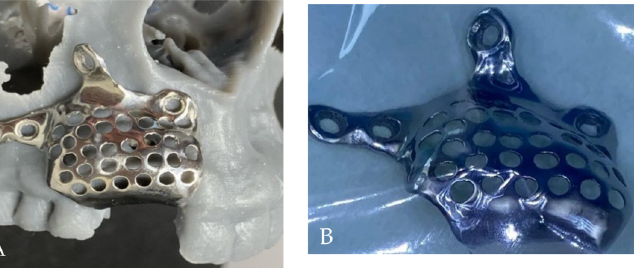
Figure 5. The custom-made titanium mesh: ( A ) on the 3D-printed bone model, ( B ) sterilized before surgery.